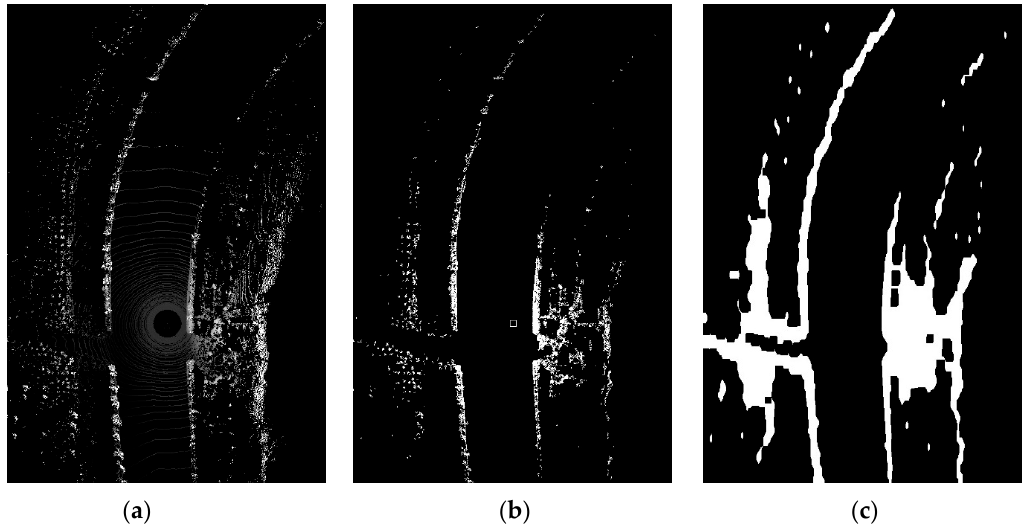
Figure 15. Result of the threshold segmentation. ( a ) Original point cloud; ( b ) Obstacle map; ( c ) Segmentation result.